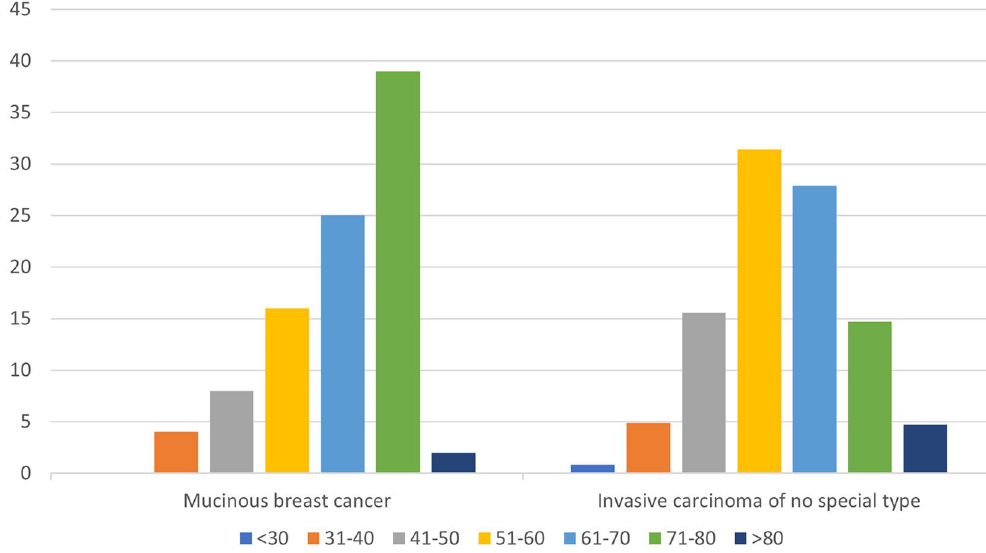
Figure 3. Age distribution of patients with mucinous and invasive carcinoma of no special